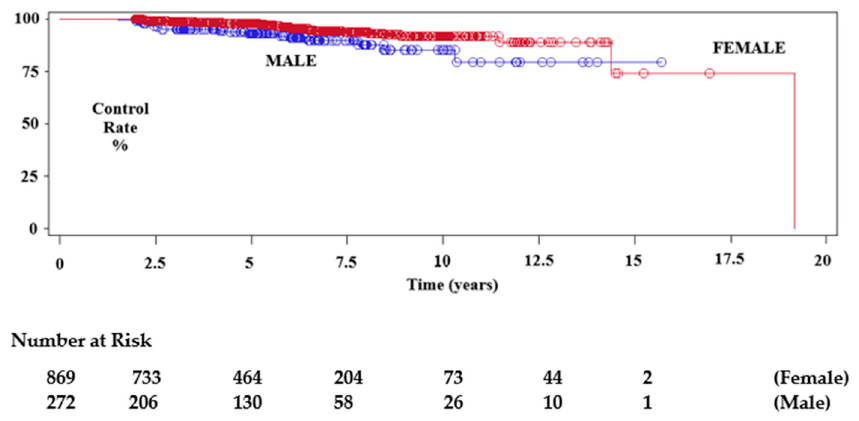
Figure 3. Kaplan–Meier test showing local imaging tumour control after SRS plotted by gender.